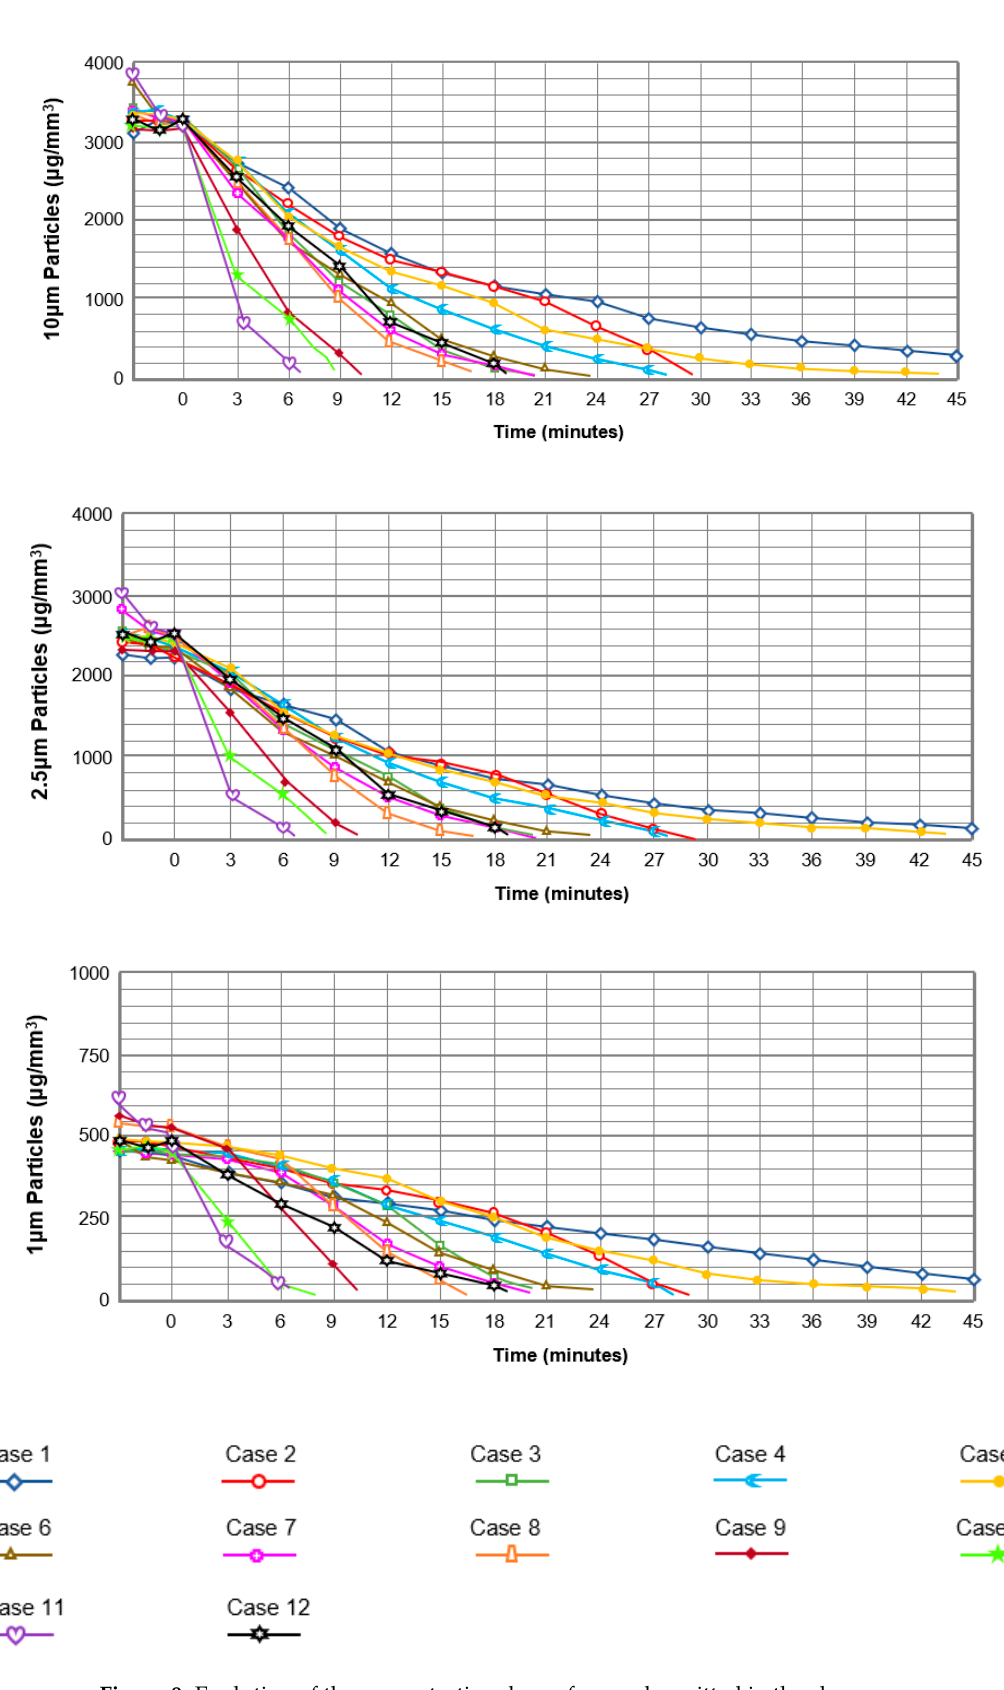
Figure 9. Evolution of the concentration drop of aerosols emitted in the classroom.